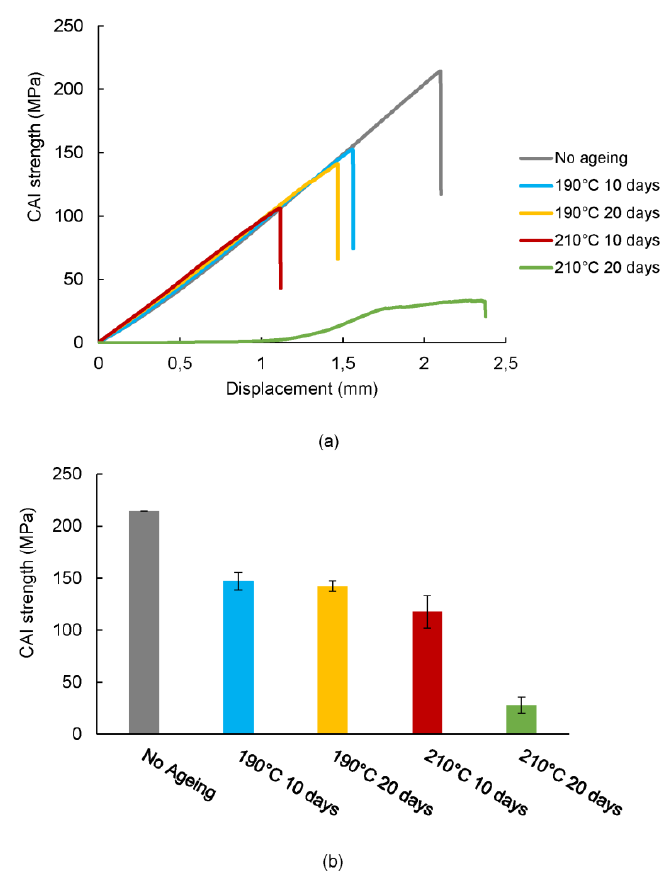
Figure 8. CAI test of thermal-aged [0/90/ ± 45] 2s quasi-isotropic laminates. ( a ) Averaged CAI Figure 8 . CAI test of thermal-aged [0/90/±45] 2s quasi-isotropic laminates. ( a ) Averaged CAI stress– stress–displacement curves. ( b ) Average CAI results and standard deviation. displacement curves. ( b ) Average CAI results and standard deviation.